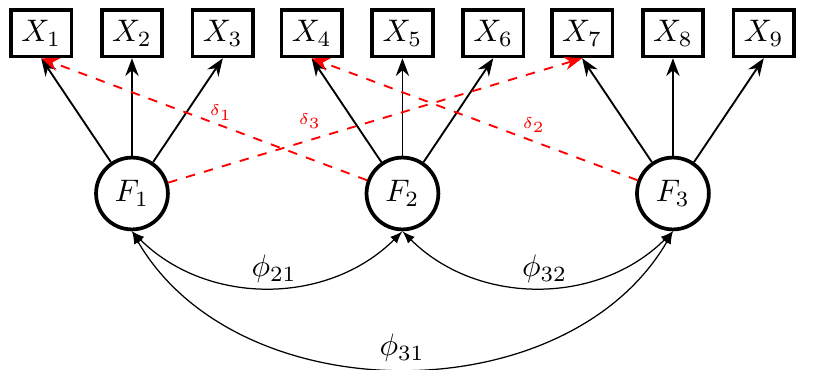
Figure 10. Simulation Study 5: Data-generating model. Cross loadings are displayed with dashed red arrows.